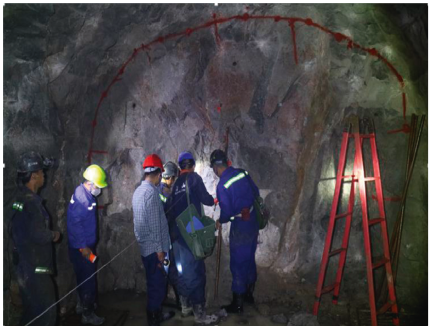
Figure 6: Preparation process of the blasting test.